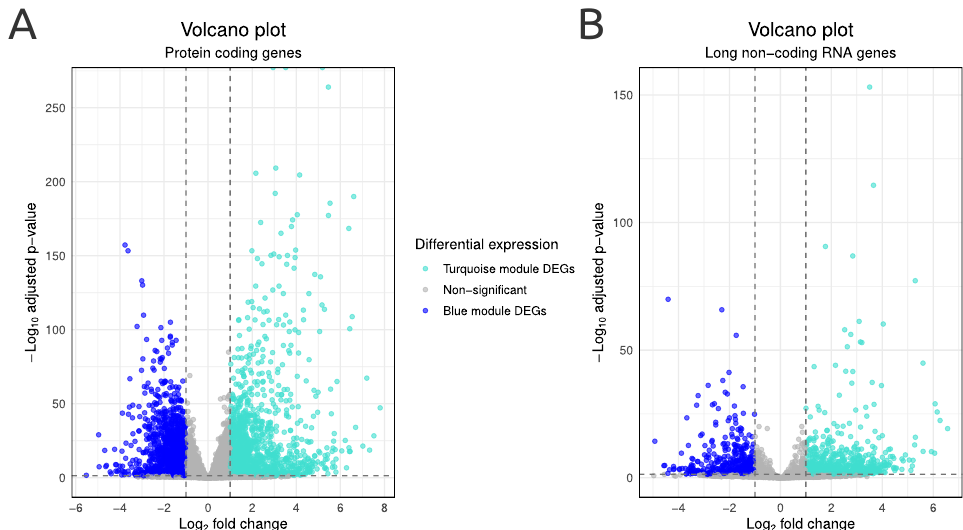
Figure 3. Volcano plots showing DEGs results, with adjusted p -value in the y-axis and | fold change | in the x-axis. Genes are divided according to their biotype: ( A ) protein-coding log 2 or ( B ) long non-coding RNA. Blue and turquoise colors represent DEGs assigned to blue (control condition) or turquoise (infection condition) modules.